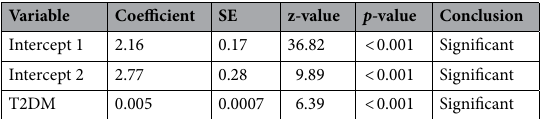
Table 5. The ANOVA of generalized Poisson regression